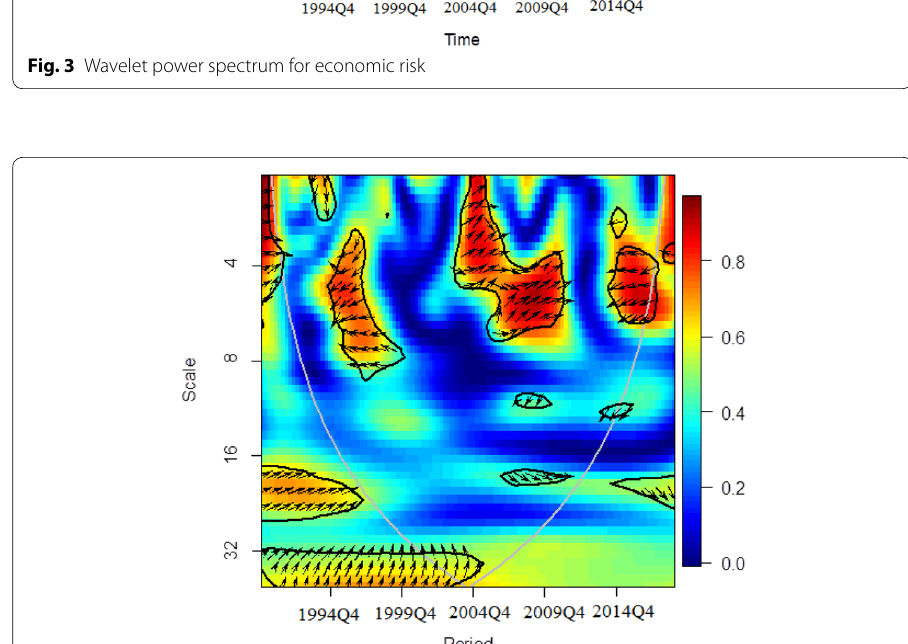
Fig. 4 Wavelet coherence between economic risk and financial